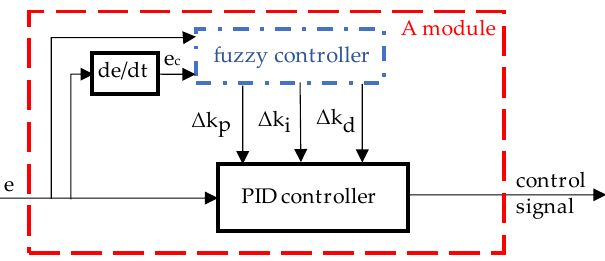
Figure 3. Block diagram of the speed controller using fuzzy PID controller.